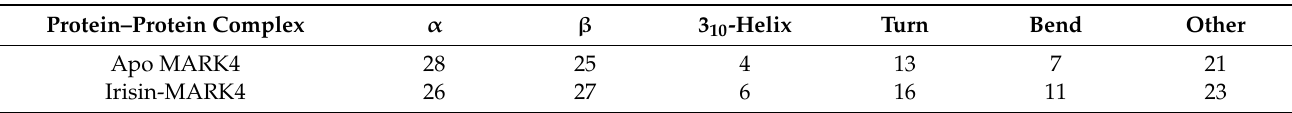
Figure 7. Secondary structure analysis ( A ) apo-MARK4 enzyme and ( B ) irisin-MARK4 complex calculated after 100 ns of MD trajectories. Table 2. Percentage of residues contributing to the secondary structure of apo MARK4 enzyme and irisin-MARK4 complex calculated after 100 ns of MD